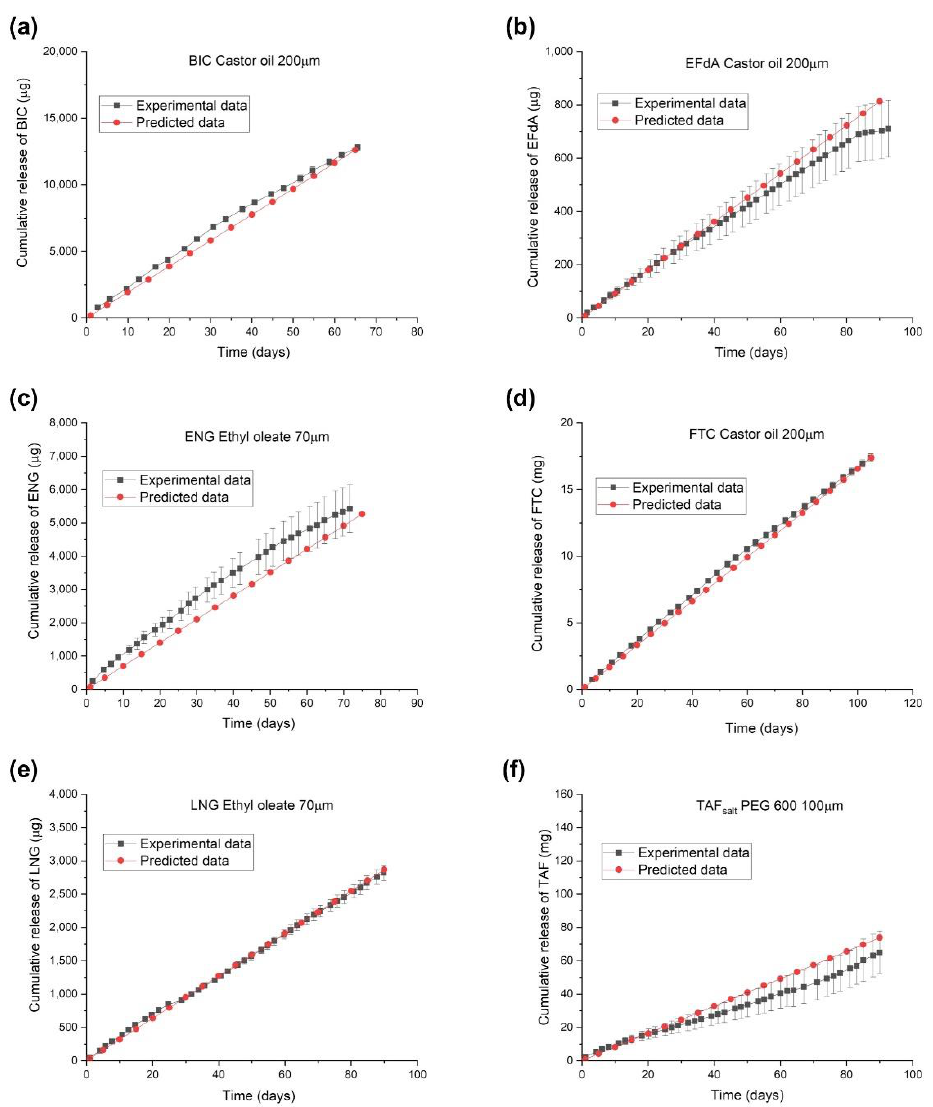
Figure 3. Predicted and experimental release profiles of implants containing a single drug with individual configurations: ( a ) BIC (castor oil, PC-17, 40 mm length, 200 µ m wall thickness, drug to